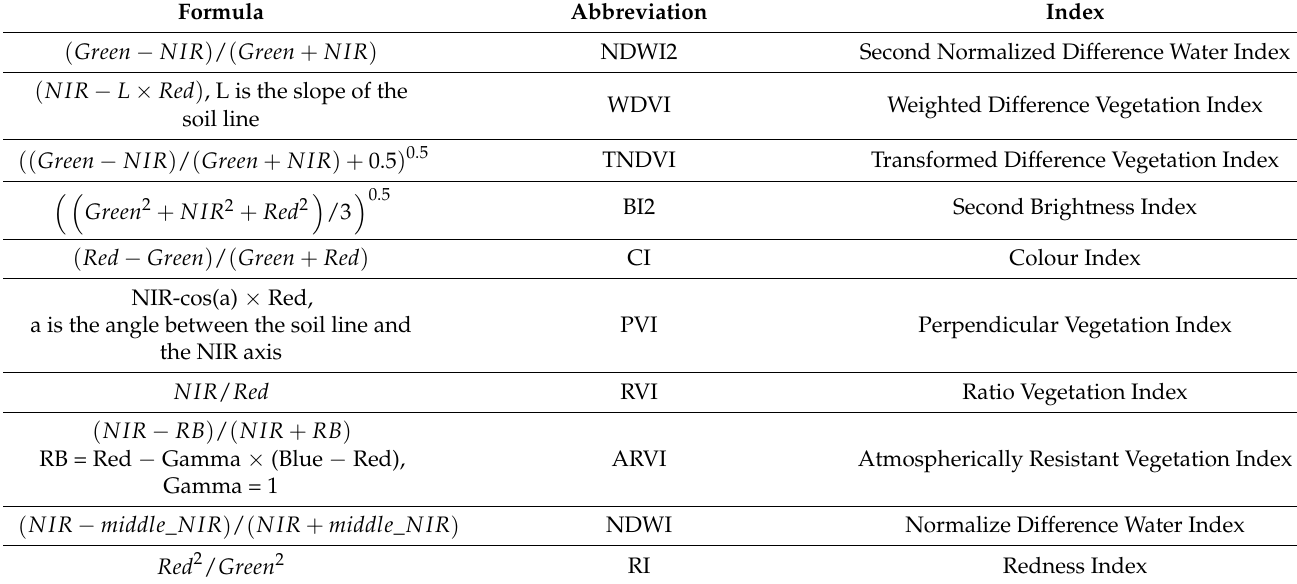
Table 3. Various types of the spectral index used for predicting objects [15].